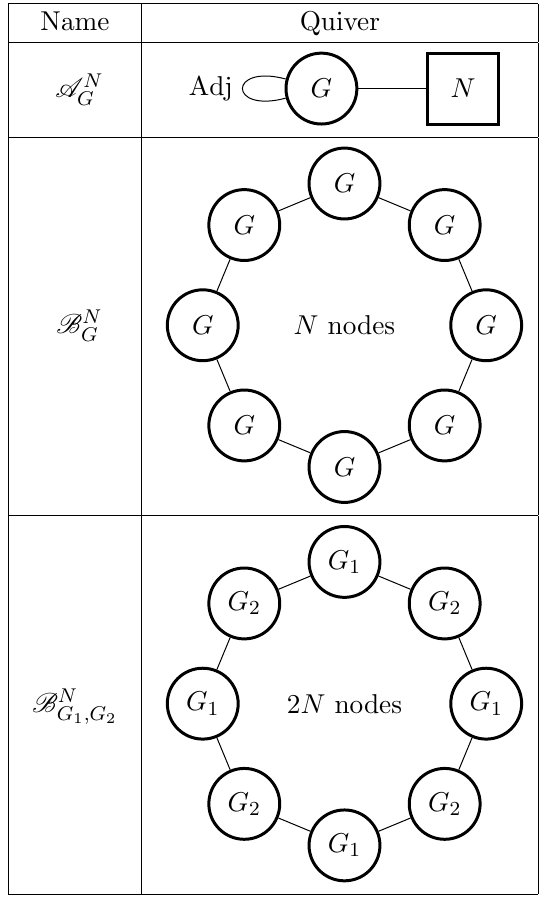
Table 1 . De(cid:12)nition of theories used in the